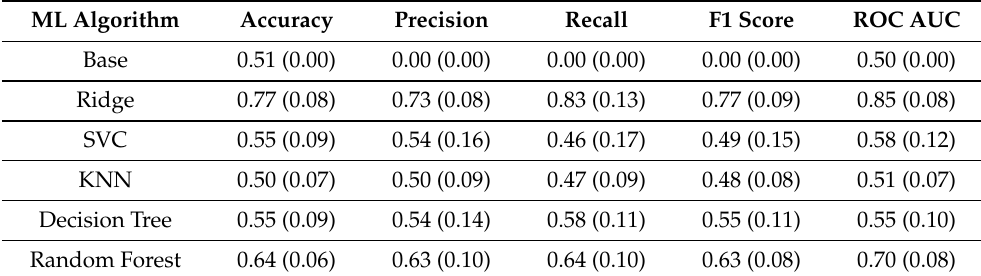
Table 11. EO prediction results (classification problem) using I-F and U-F features. Nested cross- validation with 10 outer and five inner splits. Classification problems on two classes: (a): High_EO (High Eudaimonic Orientated) and (b): Low_EO (Low Eudaimonic Oriented). Numbers are the mean value of 10 outer splits. Numbers in parenthesis indicate the standard deviation values.